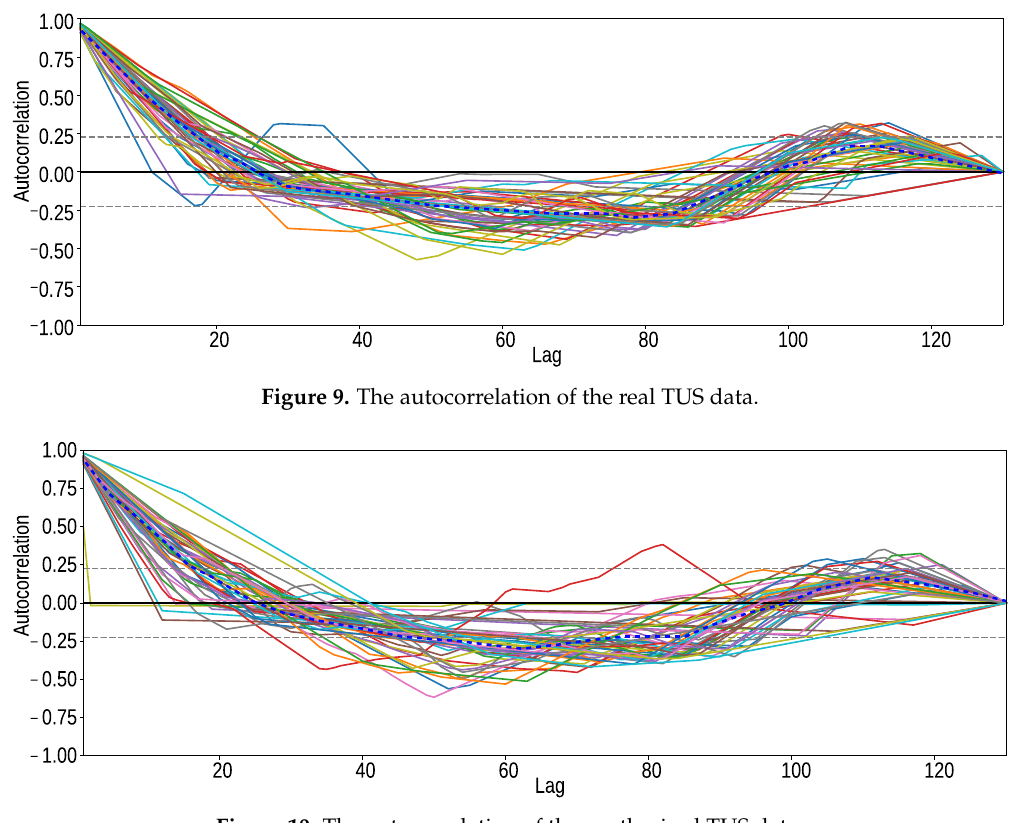
Figure 10. The autocorrelation of the synthesised TUS